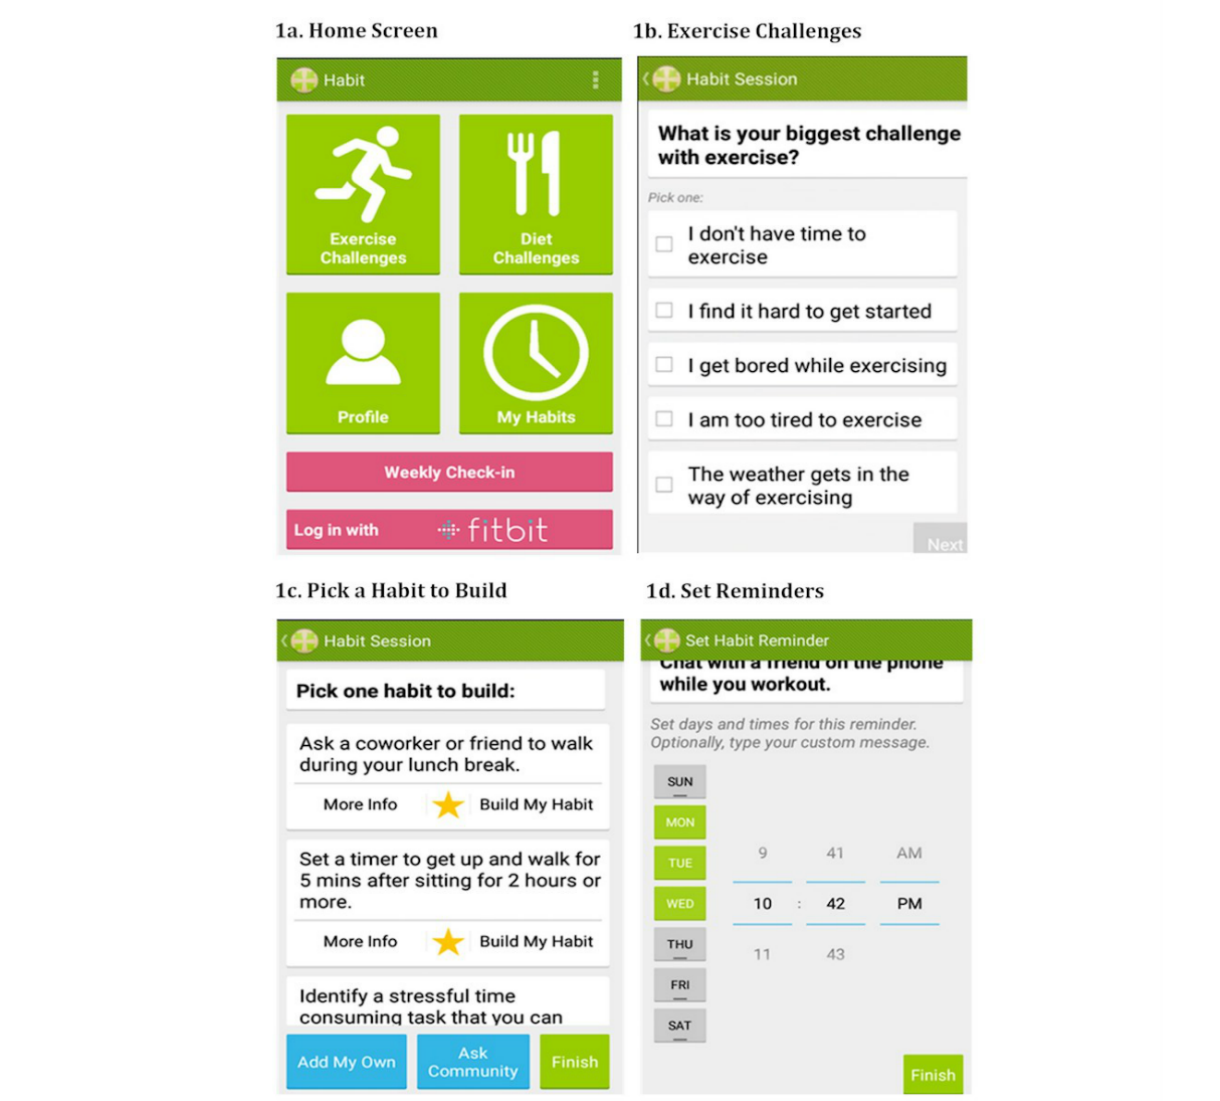
Figure 1. Habit app